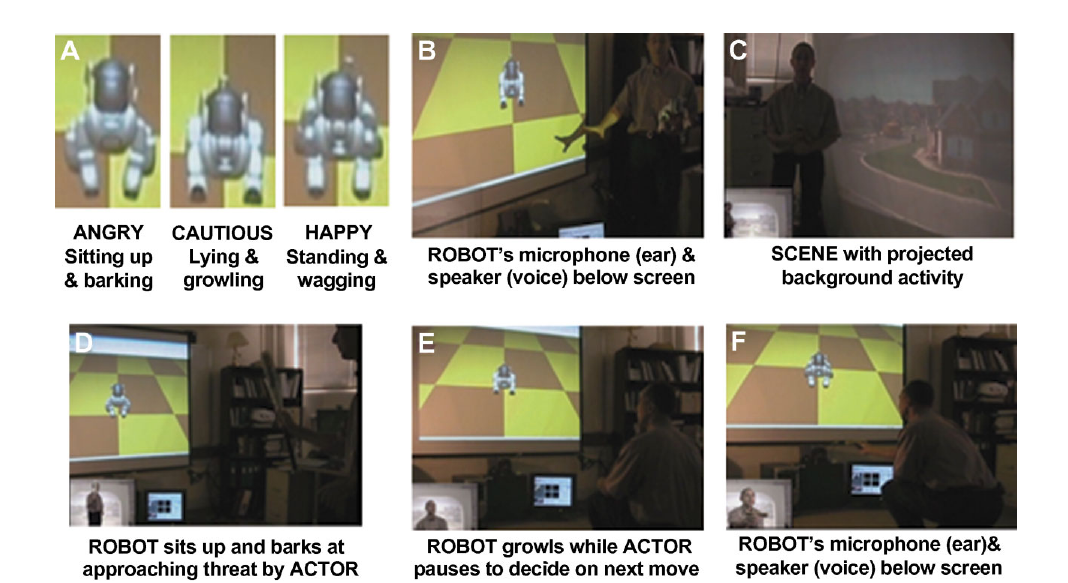
Comparison with other social robotic approaches